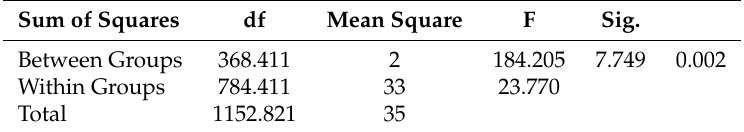
Table 15. ANOVA analysis of Random, NN and Regression with respect to final solution.